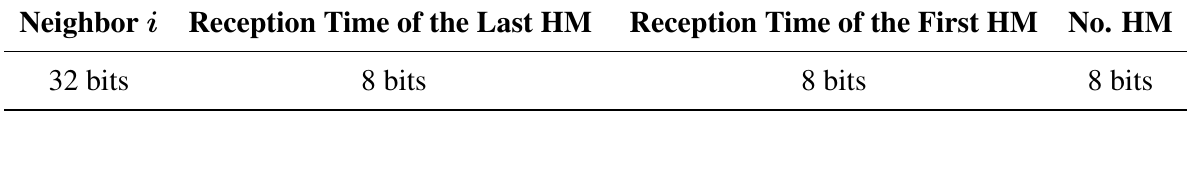
Table 2. Extra data per node used in the neighbor list included in the